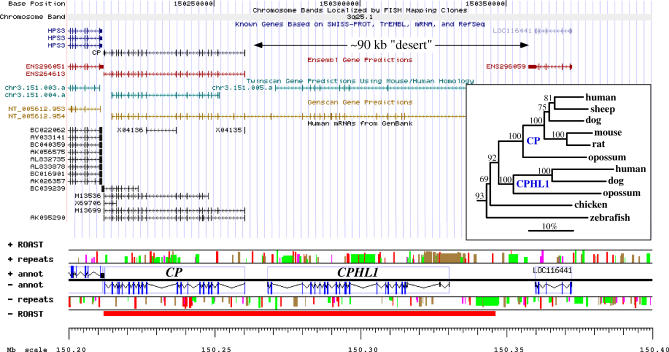

CPHL1, a Novel Ceruloplasmin-Like GeneStandard UCSC Genome Browser view of the CP locus showing a 90-kb “desert” separating it from the next known gene, LOC116441, and GESTALT view of the same locus, indicating the extent of the transcribed region predicted by ROAST (red bar in ROAST track) and the predicted gene structure for CPHL1. Interspersed repeats are color-coded, with red, green, pink, and brown bars representing Alu, MIR, LINE, and other repeats, respectively, and bar height indicating repeat age (younger repeats are taller); the megabase scale starts at the p telomere. The newly discovered gene overlaps with a gene structure predicted by Twinscan (chr3.151.005.a) but shares only seven of 21 exons, one imprecisely. GenScan predicts a much longer structure continuous with the CP gene, sharing 14 exons with CPHL1, of which ten are precisely predicted.Inset: Phylogenetic analysis of the CP/CPHL1 family rooted using the hephaestin protein sequence as outgroup. Numbers above branches represent percentage bootstrap support over 1,000 replicates; the horizontal bar indicates 10% divergence along each branch.